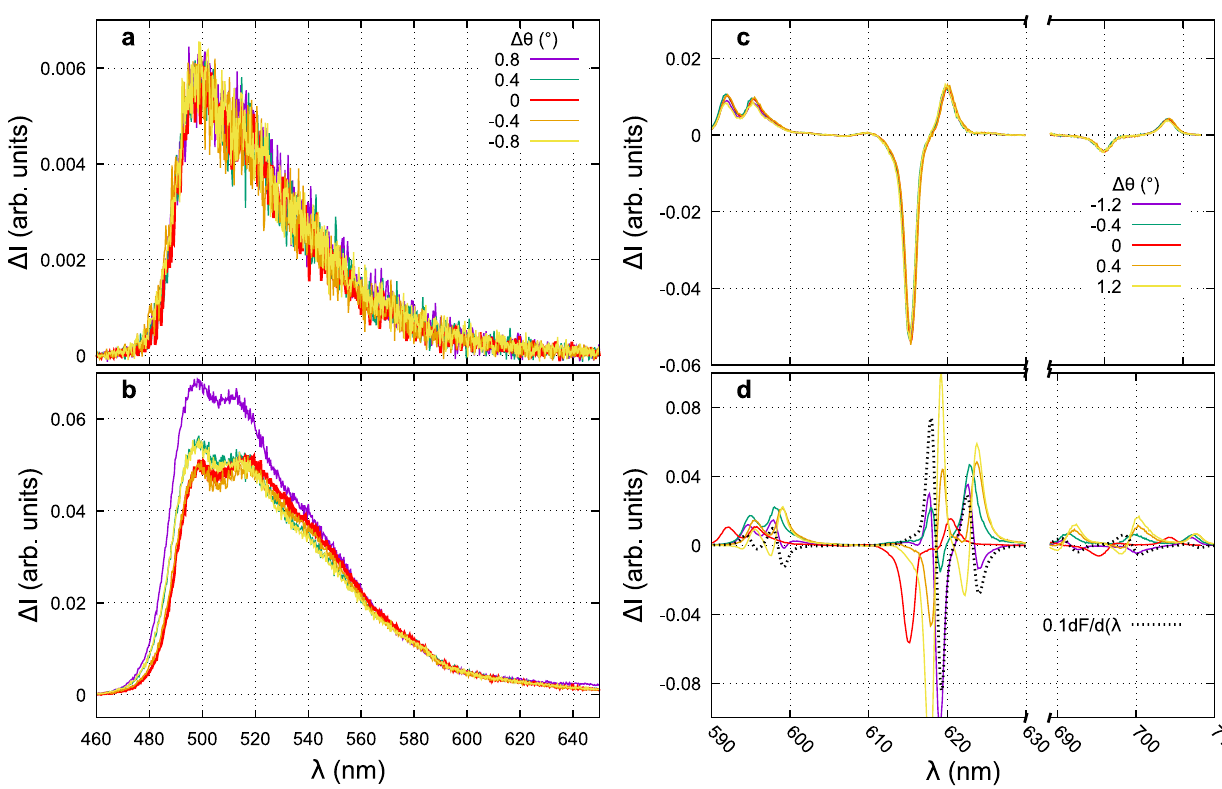
Fig.7|Artifactscomingfromwavelengthmismatch. CPLof 1 ( a , b )and 2 ( c , d )by using either the artifacts-free procedure ( a , c ) or taking one single I L -I R difference ( b , d ).Thedifferentcurvesarerecordedfordifferenttiltmis-alignmentsoftheCCD